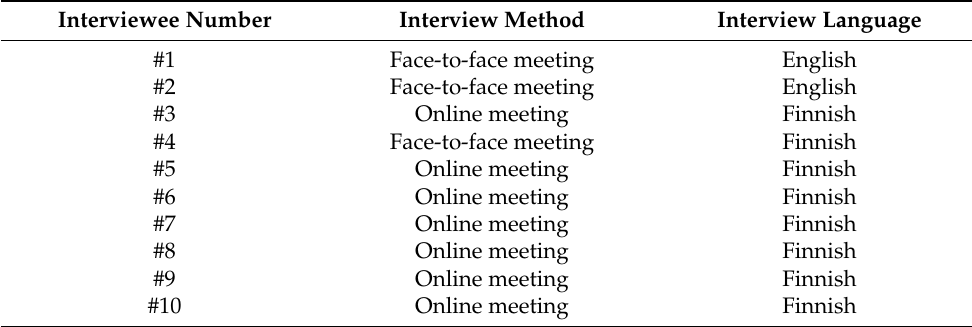
Table 3. The interview method and language of the